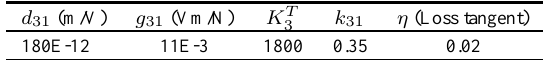
Fig. 4. Feedback current into a PZT due to shunt impedance. Table 2 Main piezoelectric parameters of G-1195 Fig. 5. Circuit diagram of a synthetic